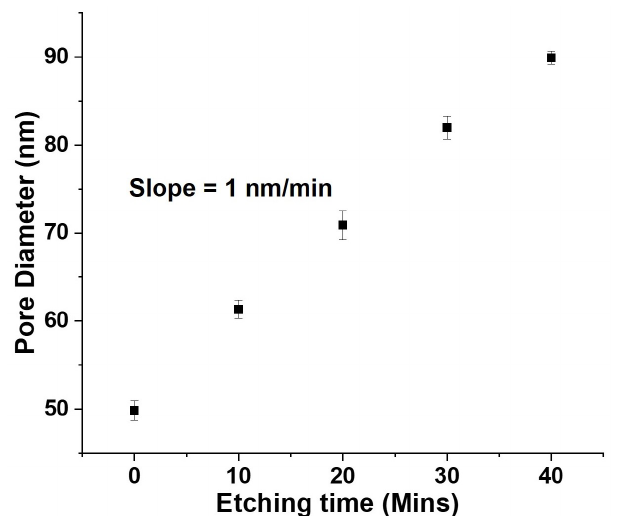
Figure 3. Correlation between the pore diameter and etching time, using data acquired from SEM imaging; slope representing an approximate etch rate of 1.0